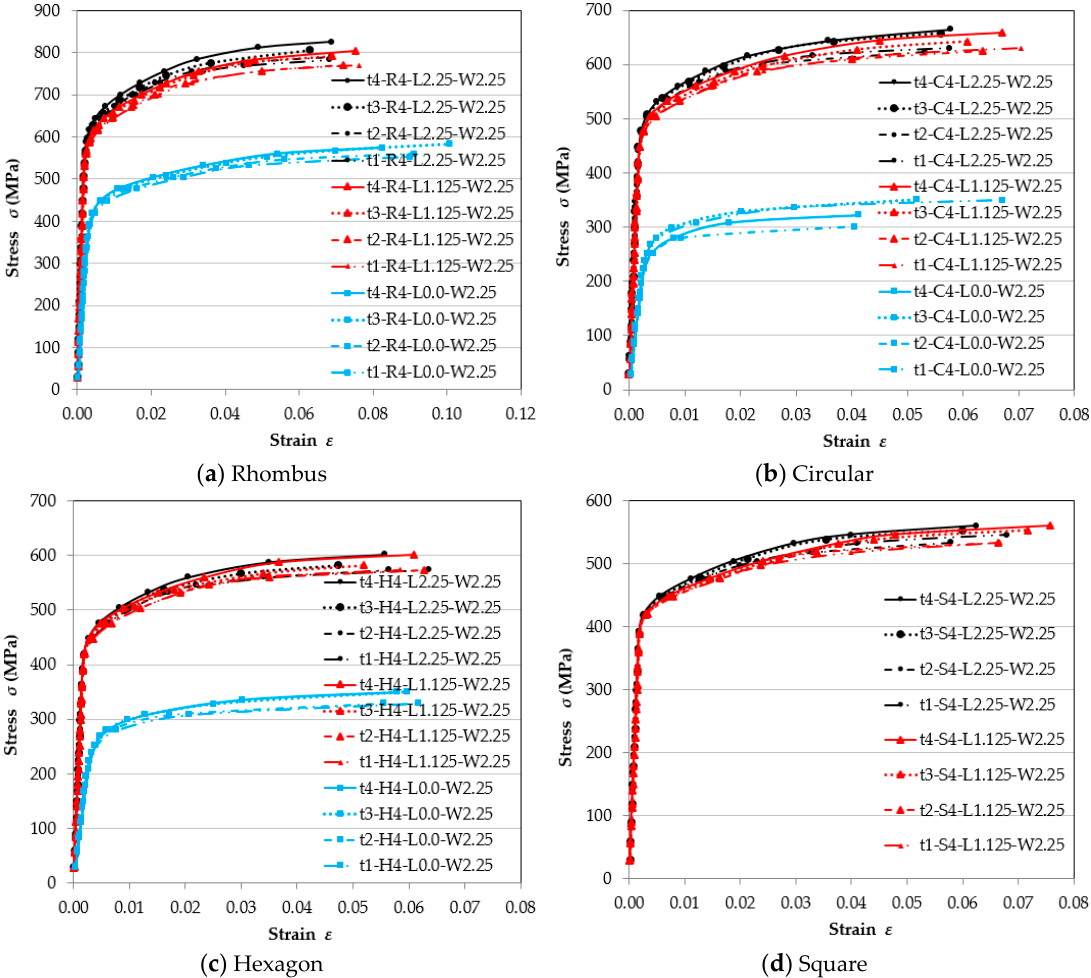
Figure 11. Stress-strain engineering relationships obtained from FE simulation for different perforated steel sheets thicknesses.